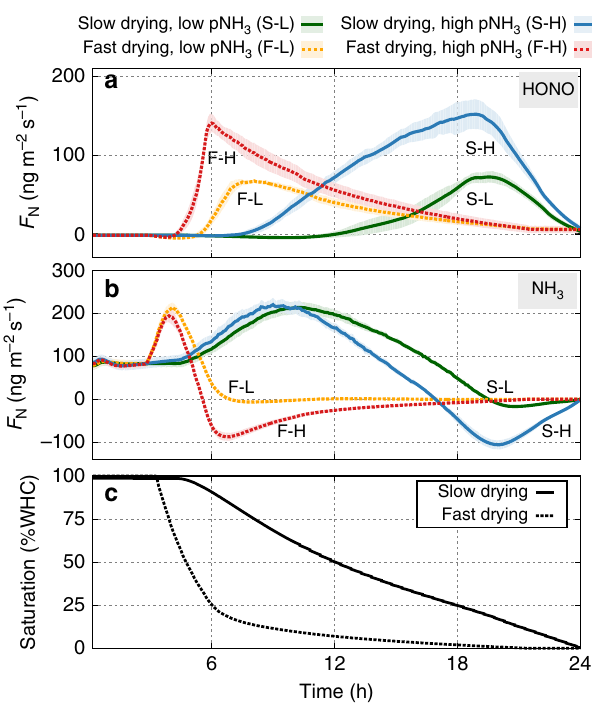
Fig. 6 Nitrogen gaseous emission dynamics under various conditions. Nitrous acid (HONO) and ammonia (NH 3 ) gaseous emissions during biocrust drying as a function of time. Typical simulations of different conditions in drying patterns (solid lines: slow drying, dashed lines: fast drying), and atmospheric NH 3 levels (low: 5 ppb, high: 20 ppb) are denoted as slow/high drying with low-/high-NH 3 level, S – L (green), S – H (blue), F – L (orange), and F – H (red), respectively. The simulated dynamics of a HONO and b NH 3 emissions are plotted during c 24 h of drying at two rates. Hydration conditions are expressed in percent of water-holding capacity. Lines are averaged values of simulations ( n = 8) and shaded areas indicate ±1 standard